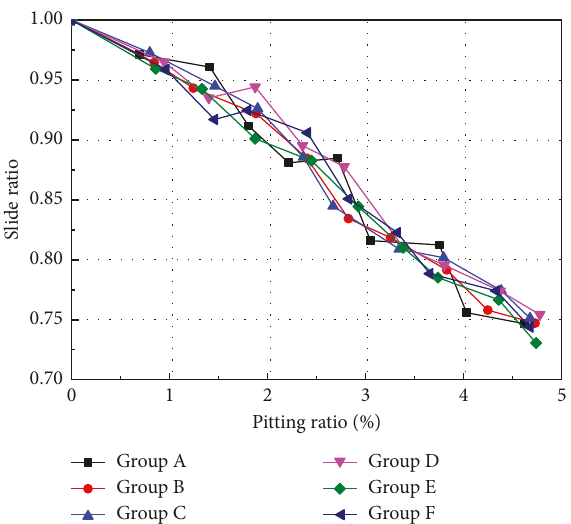
Figure 13: The relationship between the pitting ratio and slide